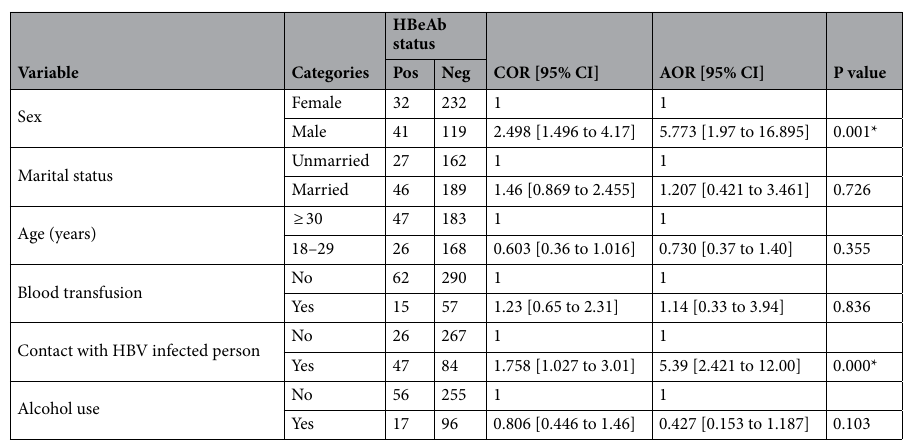
Table 4. Socio-demographic factors associated with HBeAb serostatus among HBsAg seronegative hospital attendees screened for HBV before immunization.